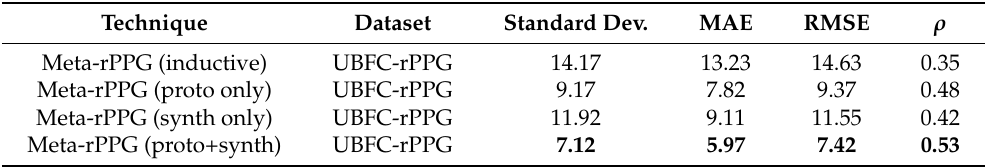
Table 5. Comparison of Meta-rPPG network results from related